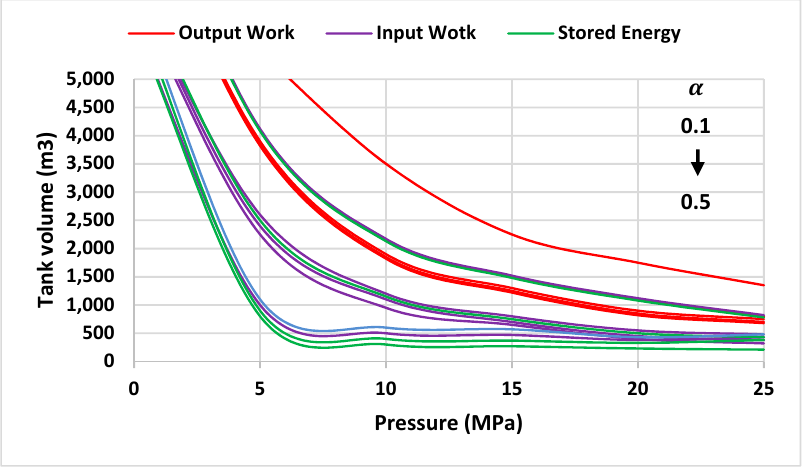
Figure 15. Reservoir volume changes about pressure for a specific input work, output work, and stored energy (5000 MJ) for different values of α (0.1 to 0.5).